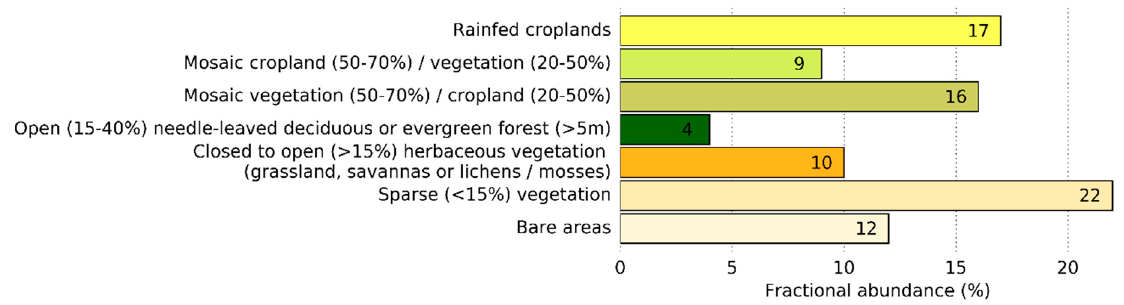
Figure 3. Land cover types of the study region with fractional abundance >1% in the study region, with sparse vegetation as the predominant land cover class with fractional abundance = 22%.